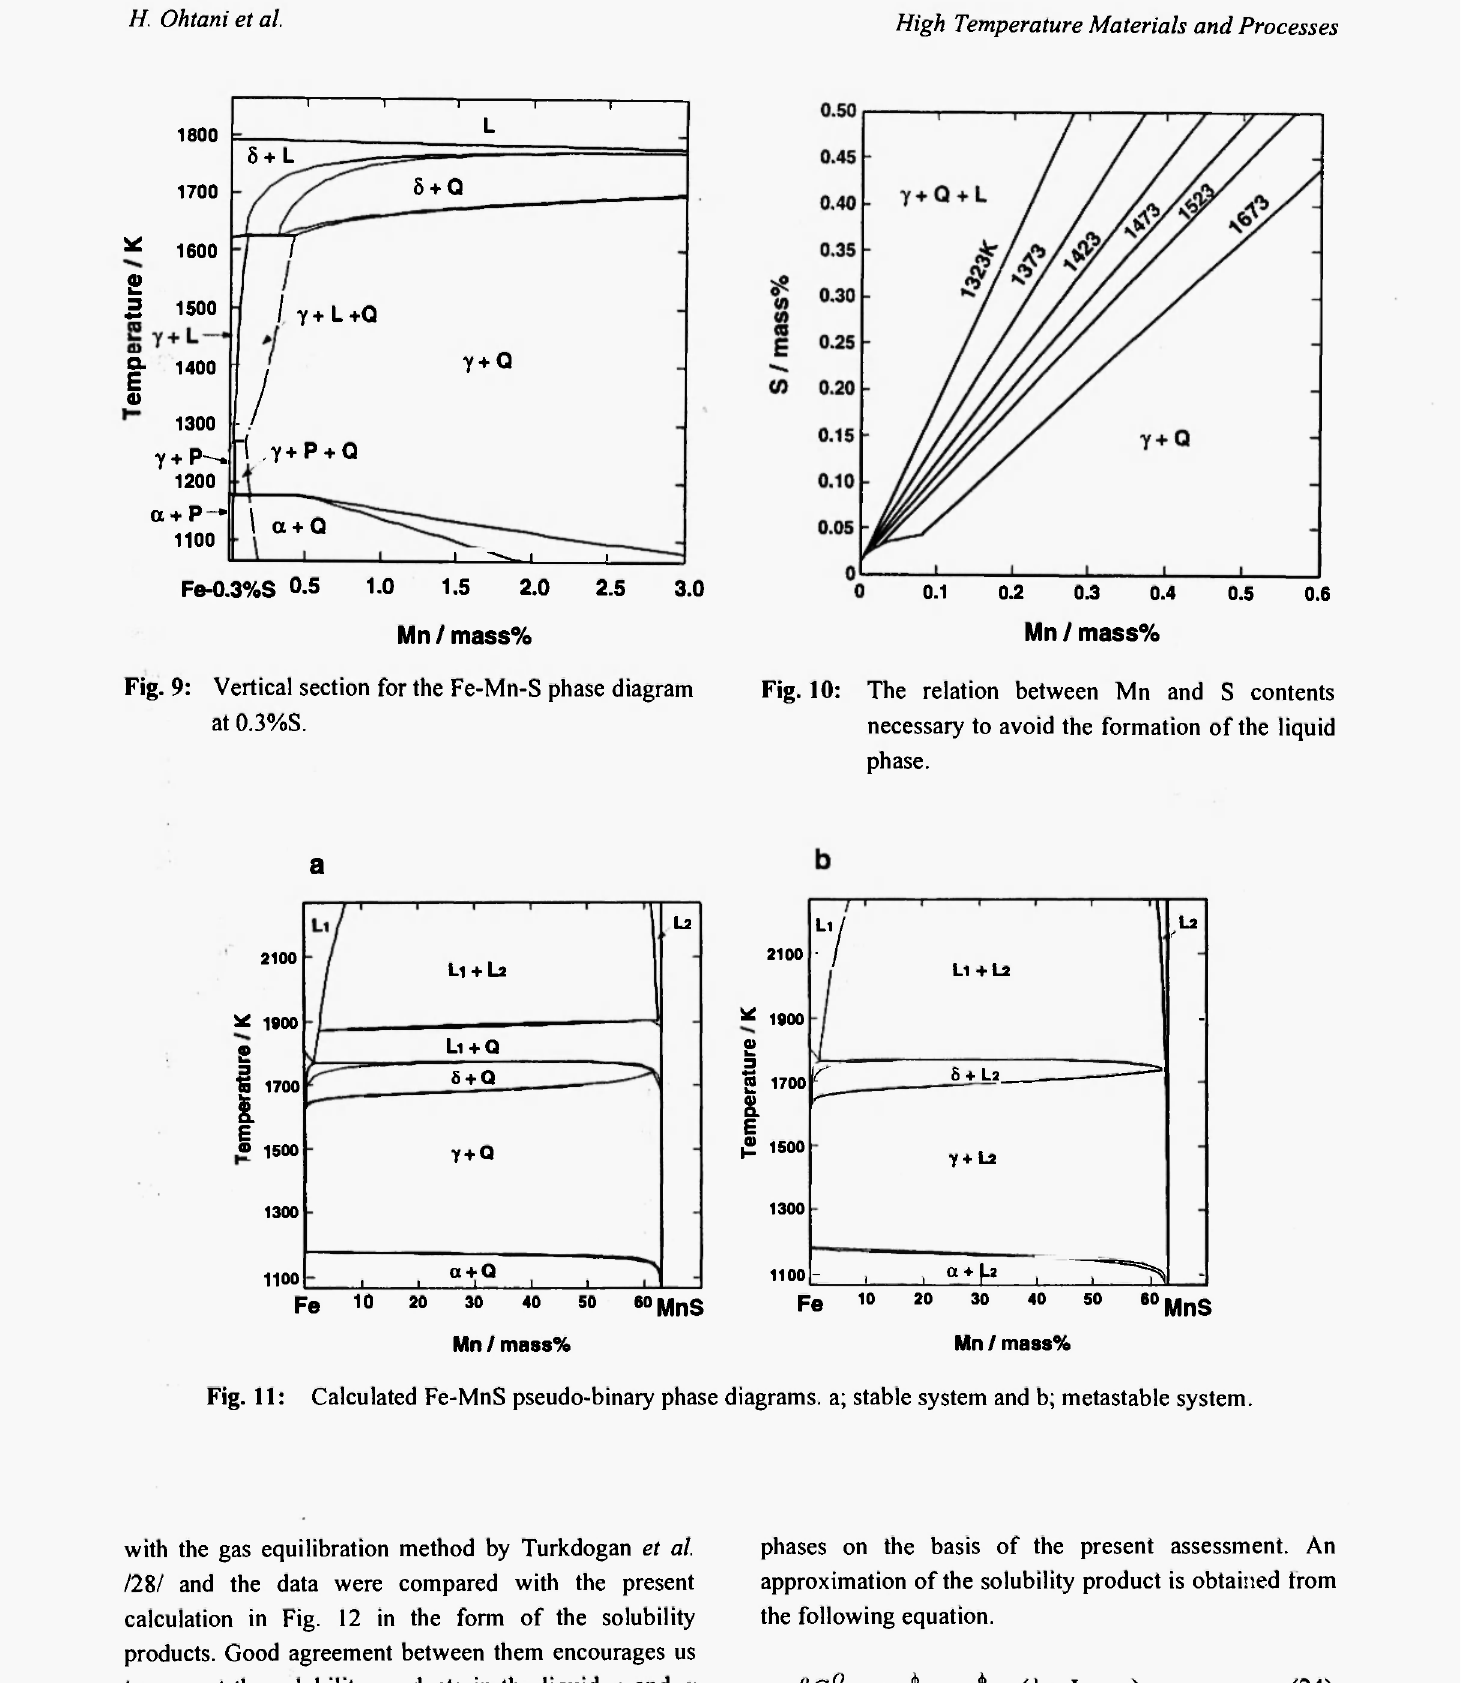
with the gas equilibration method by Turkdogan et al. phases on the basis of the present assessment. An approximation of the solubility product is obtained trom the following